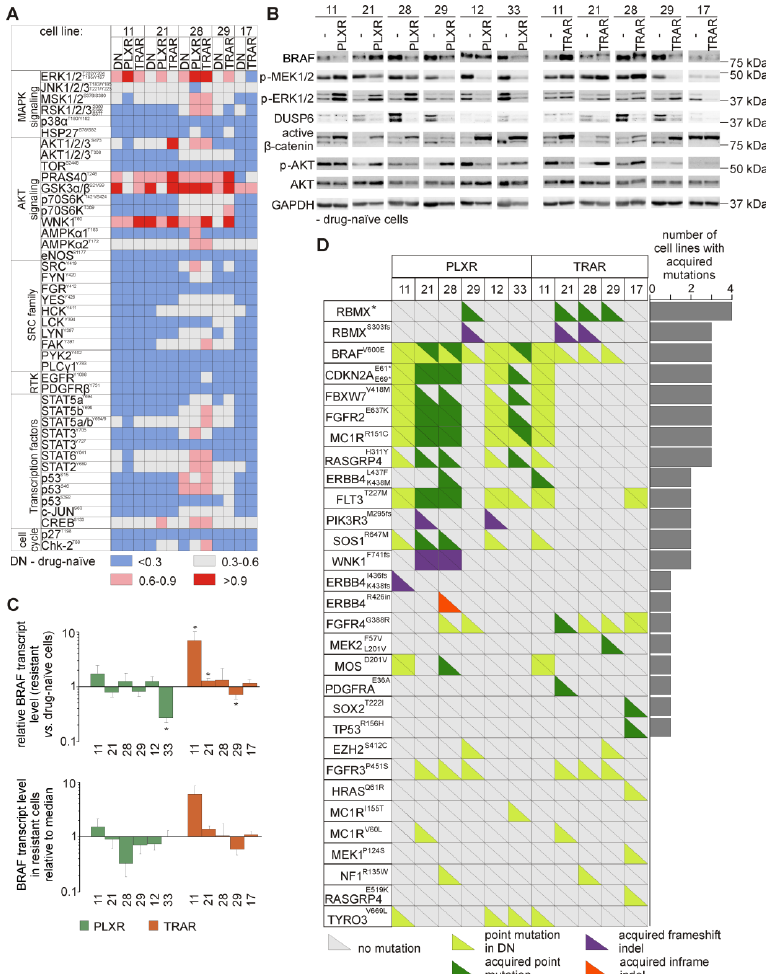
Figure 3. Melanoma cells resistant to vemurafenib (PLXR) or trametinib (TRAR) di ff er from their drug-naïve counterparts in activities of the main signaling pathways, which might be partially explained by acquired mutations. ( A ) Di ff erential activation of key signaling molecules from drug-naïve (DN) and drug-resistant (PLXR, TRAR) melanoma cells assessed by phospho-profiling. The graph shows relative levels of phospho-proteins, for which mean pixel densities were normalized to HSP60 level. Red and blue colors indicate high- and low-level phosphorylation, respectively. ( B ) Western blots showing di ff erences in expression of BRAF, DUSP6, and AKT and phosphorylation of MEK1 / 2, ERK1 / 2, β -catenin, and AKT. GAPDH was used as a loading control. n = 3, except for 12_PLXR cells ( n = 2). ( C ) BRAF transcript levels were assessed using qRT-PCR. Upper part: expression of BRAF in PLXR and TRAR cell lines relative to its expression in the matched drug-naïve cells. Bars represent mean values of 3 biological replicates ± SD, except for 12_PLXR cells ( n = 2). Di ff erences are considered significant at * p < 0.05. Lower part: transcript levels of BRAF determined in drug-resistant cells relative to the median value. ( D ) Color coded diagram of mutations acquired during the development of resistance. Mutations in genes encoding proteins of the MAPK, PI3K / AKT, RTK, and cell cycle pathways are included. See Table S1 for non-mutated genes. All mutations (SNPs and InDELs) are ranked according to the number of resistant of cell lines, in which they were detected. RBMX *: G379R +/ − , Y357H +/ − , S337N +/ − , R339G +/ − , R324P +/ −